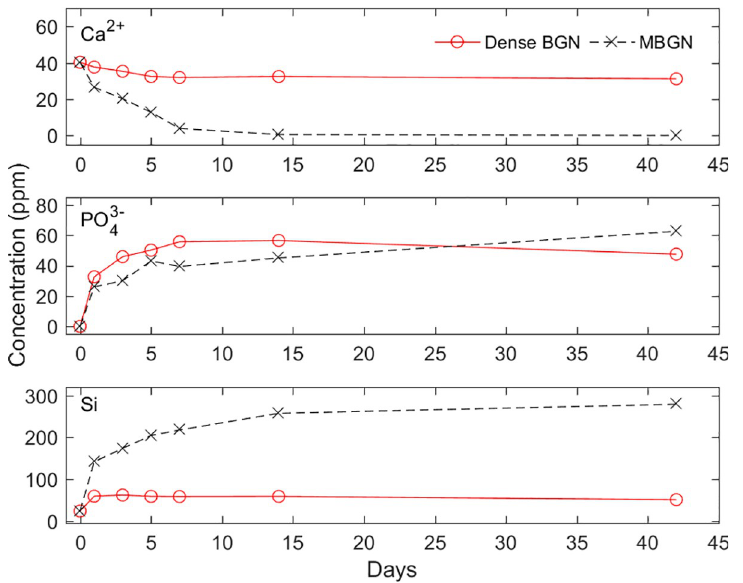
Fig 7. Change in calcium, phosphate, silicon concentration over time.